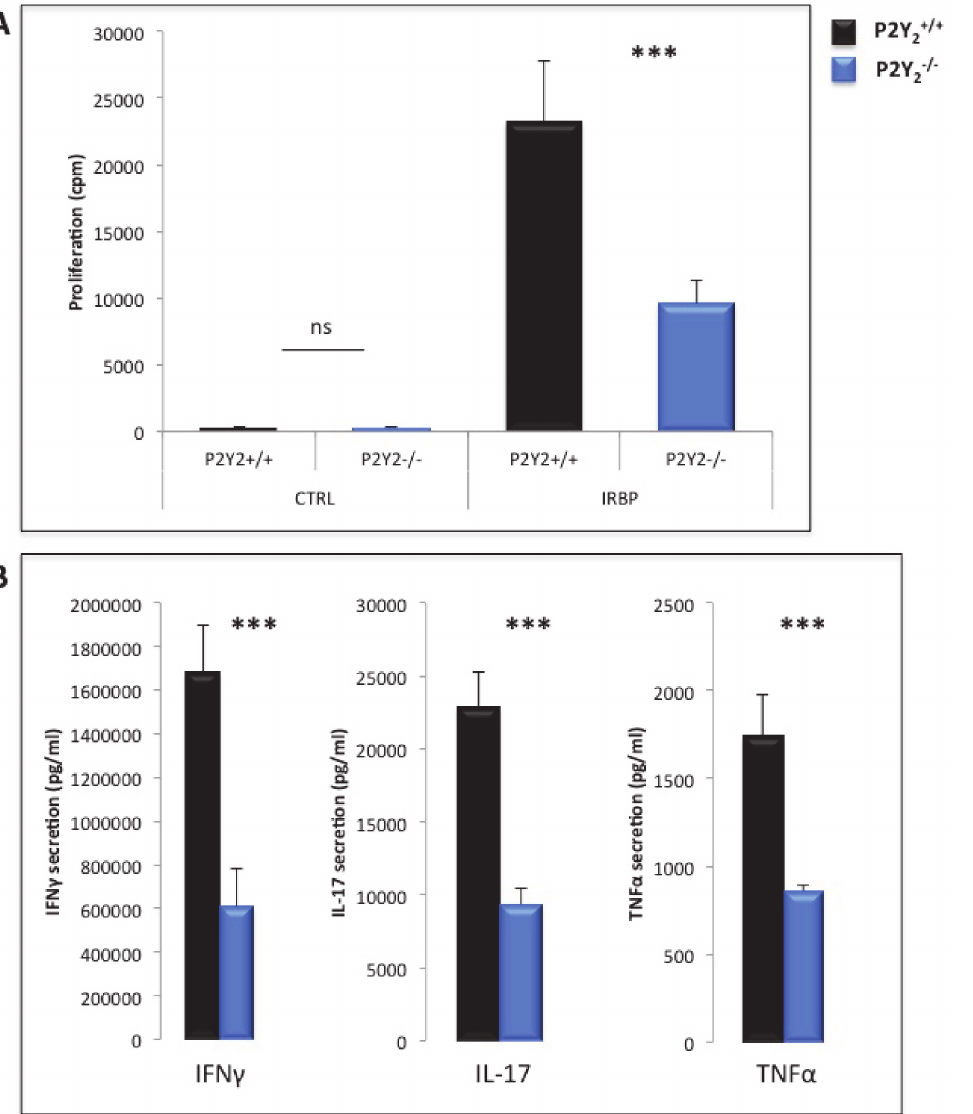
Fig 5. P2Y 2-/- TL proliferate less and secrete less cytokines in response to in vitro IRBP restimulation. Twelve days after s.c. immunization with IRBP 1 – 20 peptide, P2Y 2+/+ and P2Y 2-/- mice were sacrificed and their spleen and draining lymph nodes collected and dissociated. (A) Splenic TL were semi- purified by passage on nylon wool fiber columns and pooled with LN cells before being in vitro restimulated in medium alone (CTRL) or supplemented with IRBP 1 – 20 peptide. TL proliferation was tested after 72h by ( 3 H)- incorporation. Data are from a representative experiment of 10 with 4 mice per group. (B) Cytokine secretion was quantified, by specific ELISA, in culture supernatants after 48h of IRBP restimulation. Data are from a representative experiment of 5 or 6 or 3 respectively, with 4 mice per group. ns: not significant; ** p < 0,01; *** p <